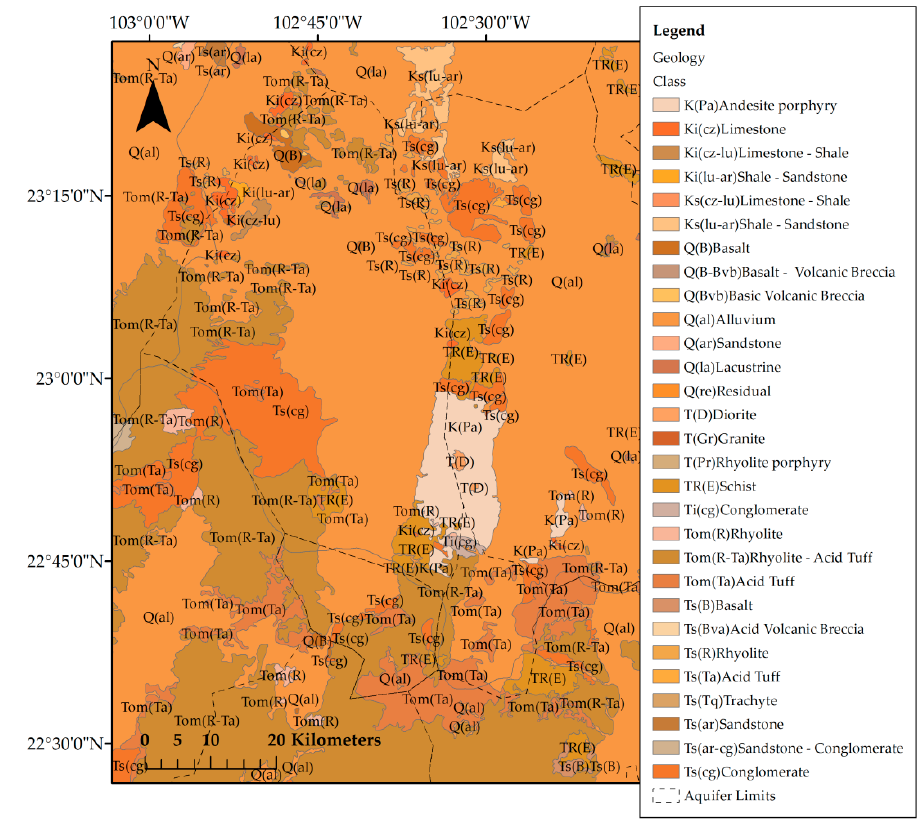
Figure 2. Geological setting map of the study area.